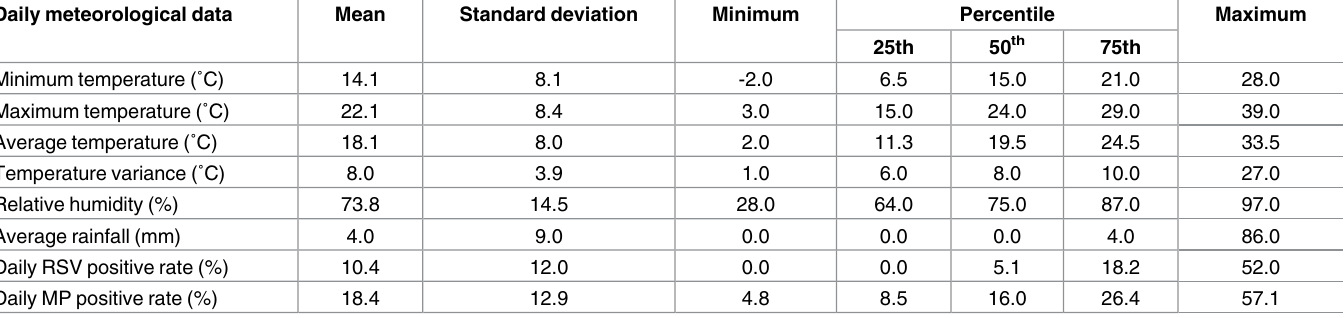
Table 2. Descriptivestatistics for RSV and MP infection and meteorological data between January 2015 and December2015 in